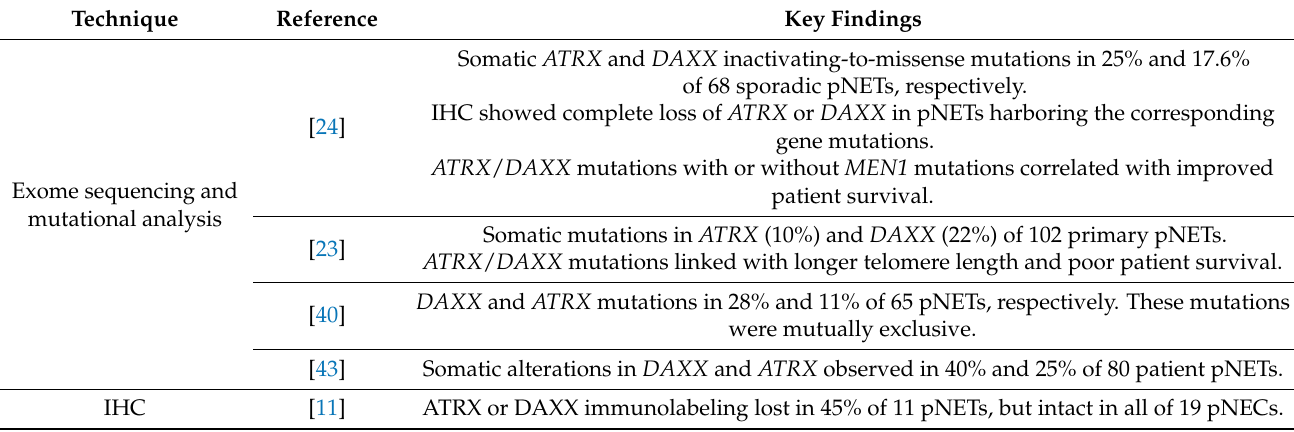
Table 5. Molecular profiling studies revealing ATRX/DAXX alterations in